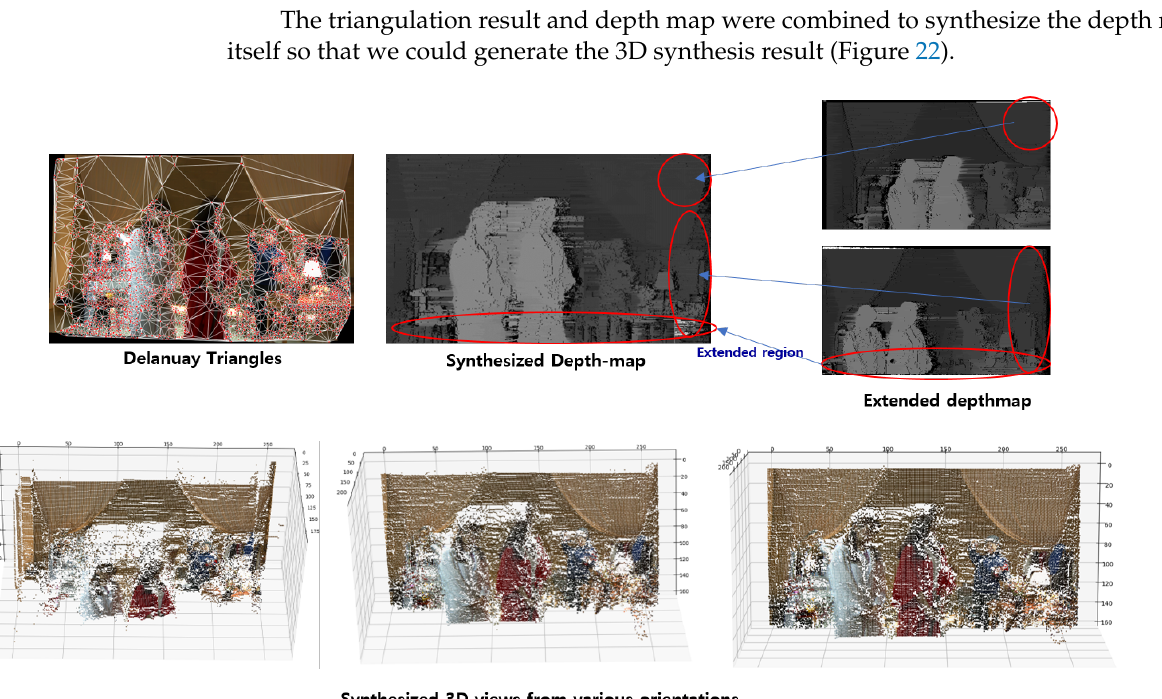
Figure 22. View synthesis with four images is extended in the vertical and horizontal